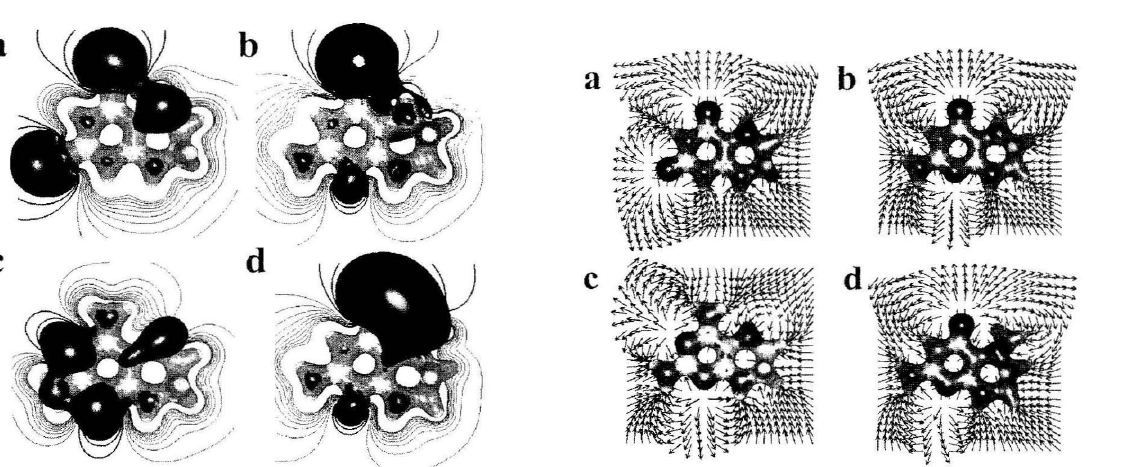
Figure 4. Electron densit" isosurfaces (0.10 a.lI.), mapping local electrostatic potential, and vector fields depicting the local gradients of the molecular electrostatic potential functions of the compunds studied (see text for details). a) tetrah~'drolumazine, b) tetrahydropterin, c) 4-amino tetralwdropterin, d) N5-methvl